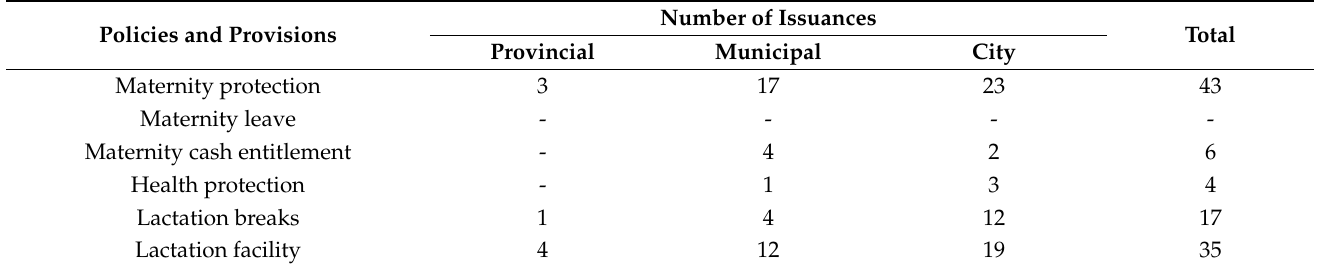
Table A2. Summary of local ordinances related to breastfeeding promotion and maternity protection 1